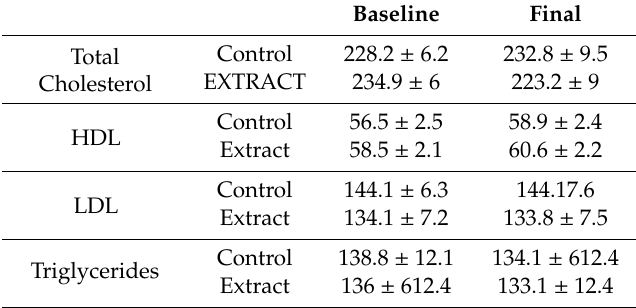
Table 1. Evolution of biochemical blood parameters of subjects during the study.